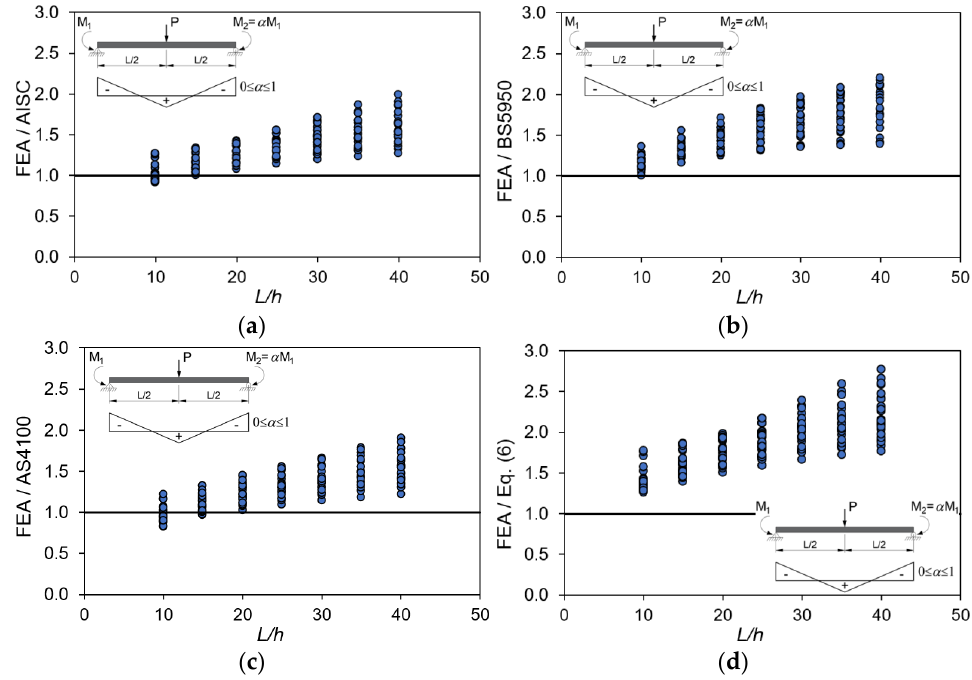
Figure 10. Comparison of elastic critical LTB for LC 2 between FEA results and existing equations. ( a ) AISC [1], ( b ) BS 5950 [4], ( c ) AS 4100 [2], ( d ) Helwig’s study [17].